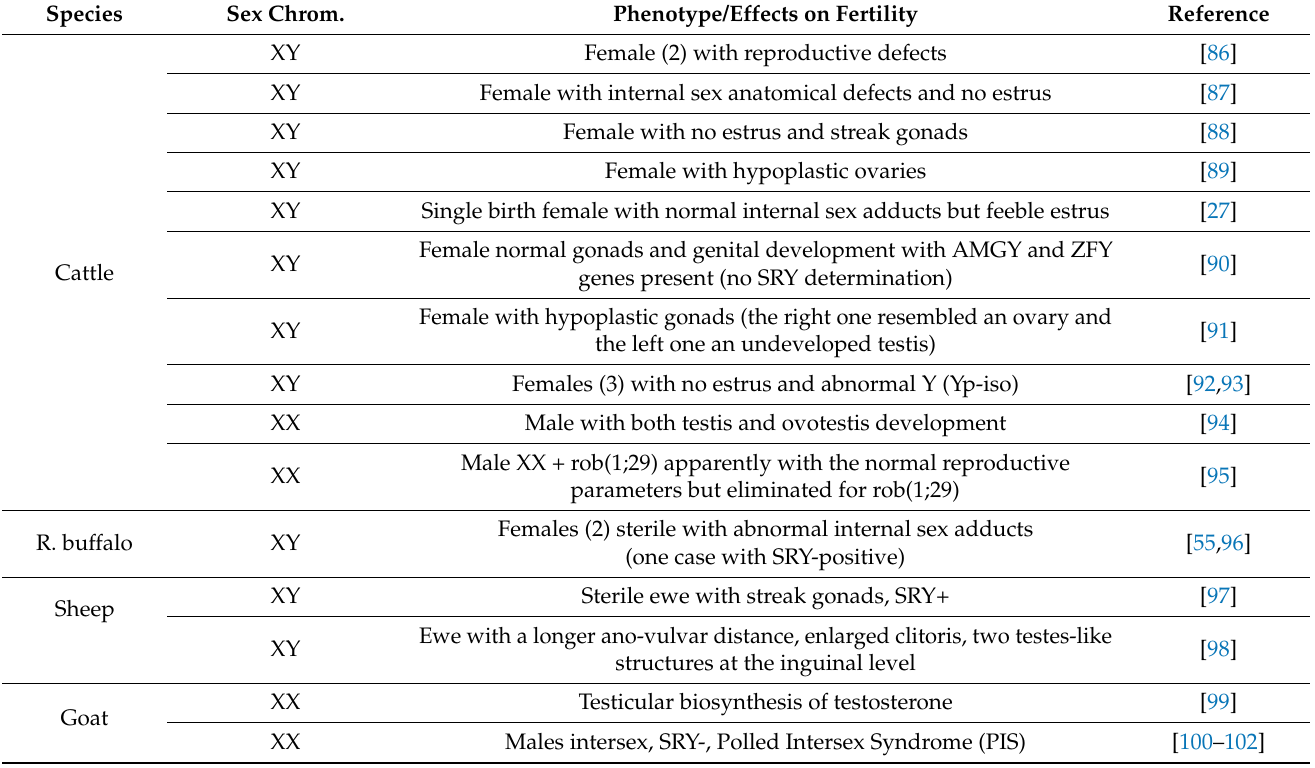
Table 6. Cases with sex reversal syndrome in domestic